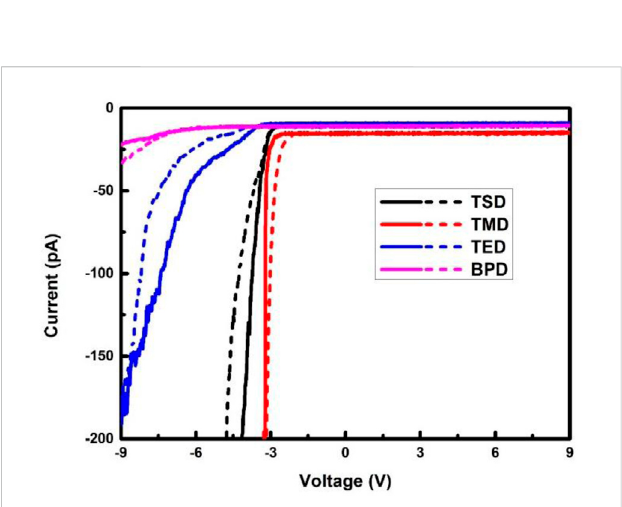
FIGURE 4 Localized I - V curvesofTSD,TMD,TED,andBPDin4H-SiCepitaxial